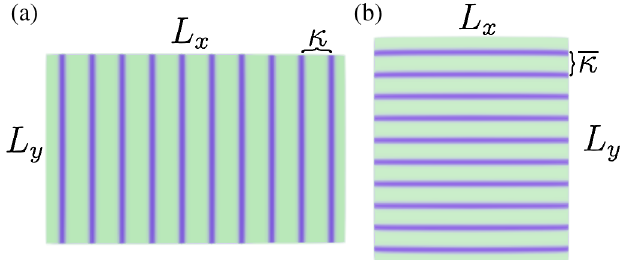
ð z Þ and (cid:1) ’ ð z Þ , on the n n x